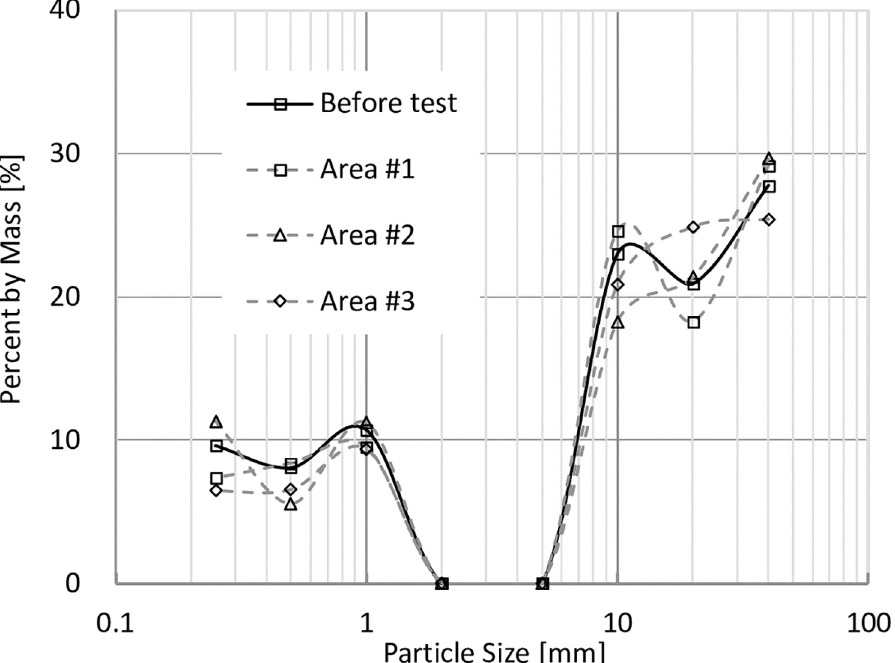
Fig 17. Frequency of particles with different sizes in each area of the model with VFR = 80%.